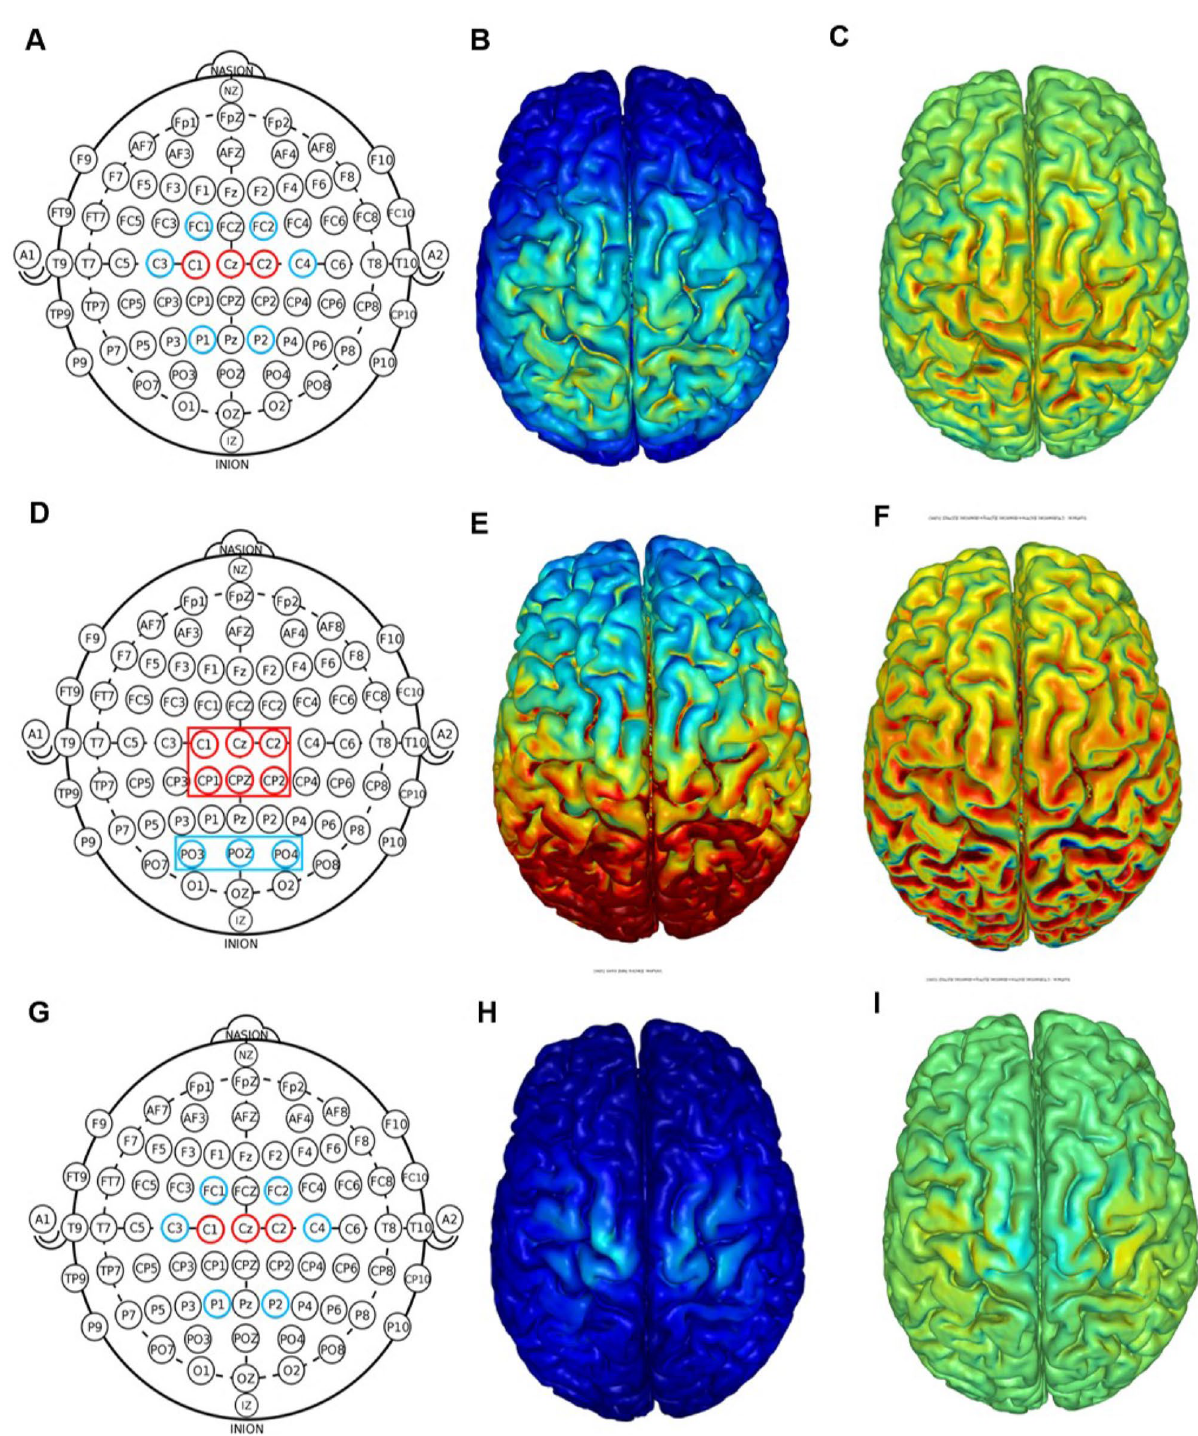
Figure 2. Transcranial direct current stimulation montages used in the present study: high-definition (top row), simulated conventional (middle row), and active sham (bottom row). Ring electrode positions (red = anodal electrode; blue = cathodal electrode) according to the EEG 10/20 system ( A , D , G ). For the conventional montage, ring electrodes were used to simulate the rectangular electrodes ( D ). Computational modeling of the finite element model of the total ( B , E , and H ) and radial ( C , F , and I ) electric fields induced by high-definition and active sham tDCS. All figures are displayed with a field intensity of 0.30 V/m (directionless. blue = zero electric fields; red = peak magnitude). Radial electric field ( C , F , and I ) considers the direction of current (blue = peak outward current; green = zero normal current; red = peak inward current). Note: panels B, C, E, F, H, and I was generated by the HD-Explore software (Version 2.3, Soterix Medical, New York, NY; https:// soter ixmed ical. com/ resea rch/ softw are/ hd- explo